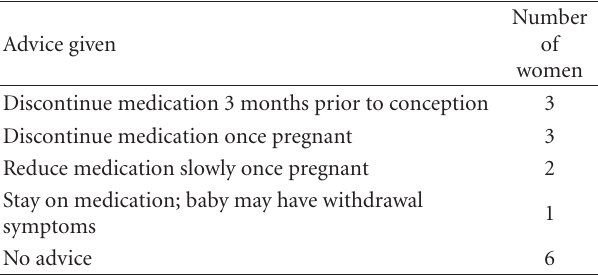
Table 3: Advice given to patients.